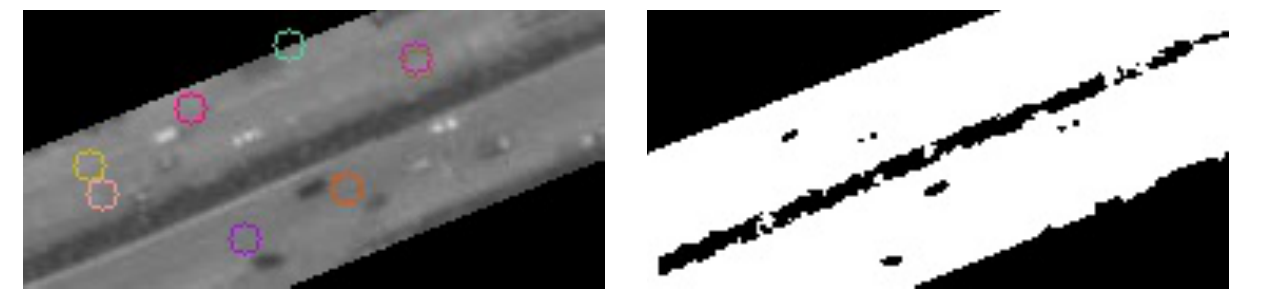
Figure 5: Seeds in road buffer. The center of every small circle represents the seed.